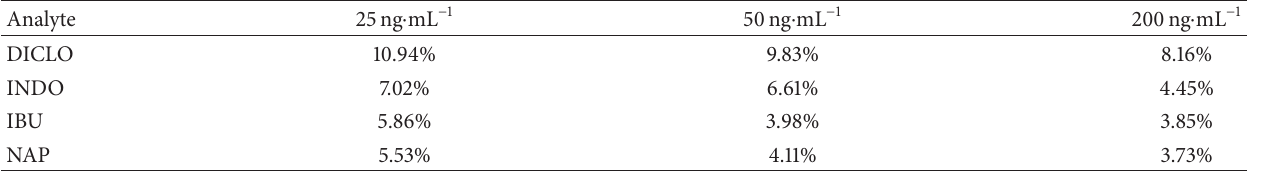
Table 2: Average relative standard deviation (RSD) for spiked drugs (𝑛 = 6) .